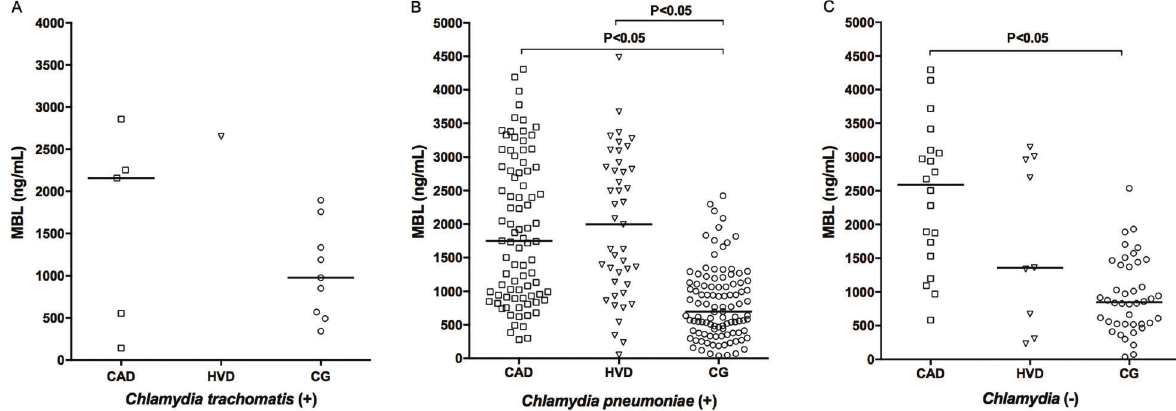
Figure 3. Distribution of mannose-binding lectin (MBL) plasma levels in patients with coronary artery disease undergoing coronary artery bypass surgery (CAD), patients with heart valve disease undergoing valve replacement (HVD) and a control group (CG) sero- positive only for C. trachomatis ( A ), seropositive only for C. pneumoniae ( B ), and seronegative for Chlamydia ( C ). Data are reported as medians (Mann-Whitney test).